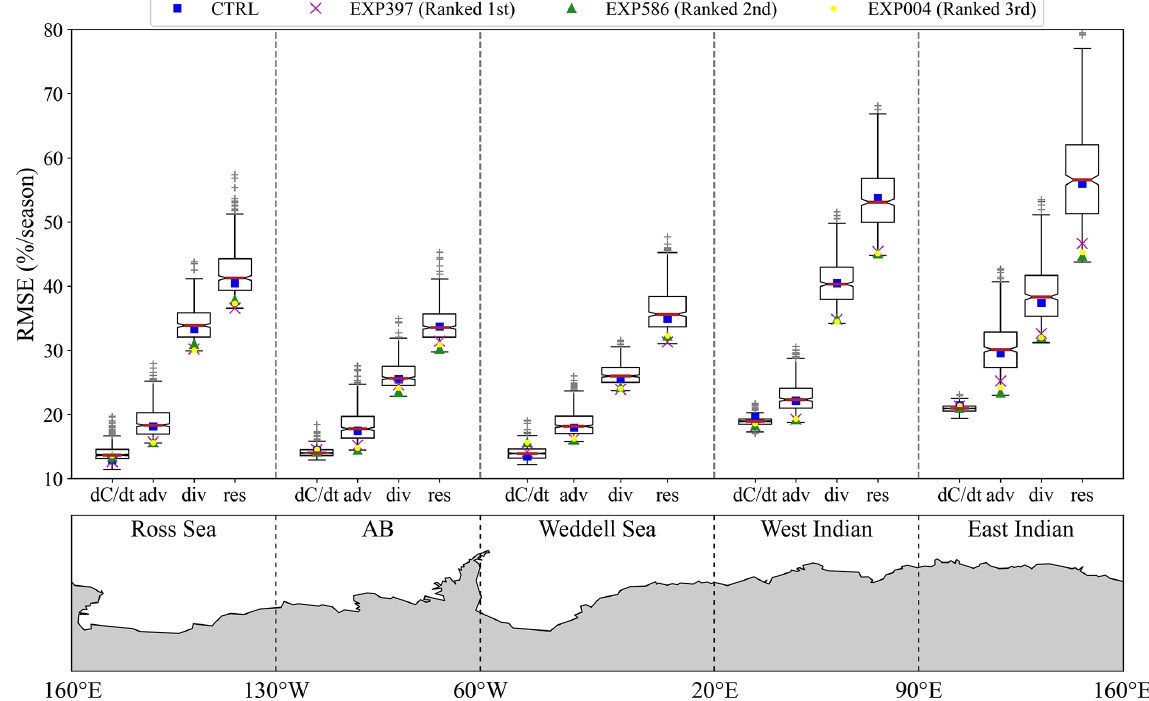
Figure B6. The same as Fig. 7, but the RMSE of each SIC budget term is averaged over four seasons and counted separately in each Southern Ocean sector. The dotted vertical line marks the demarcation of each sector. AB: Amundsen–Bellingshausen